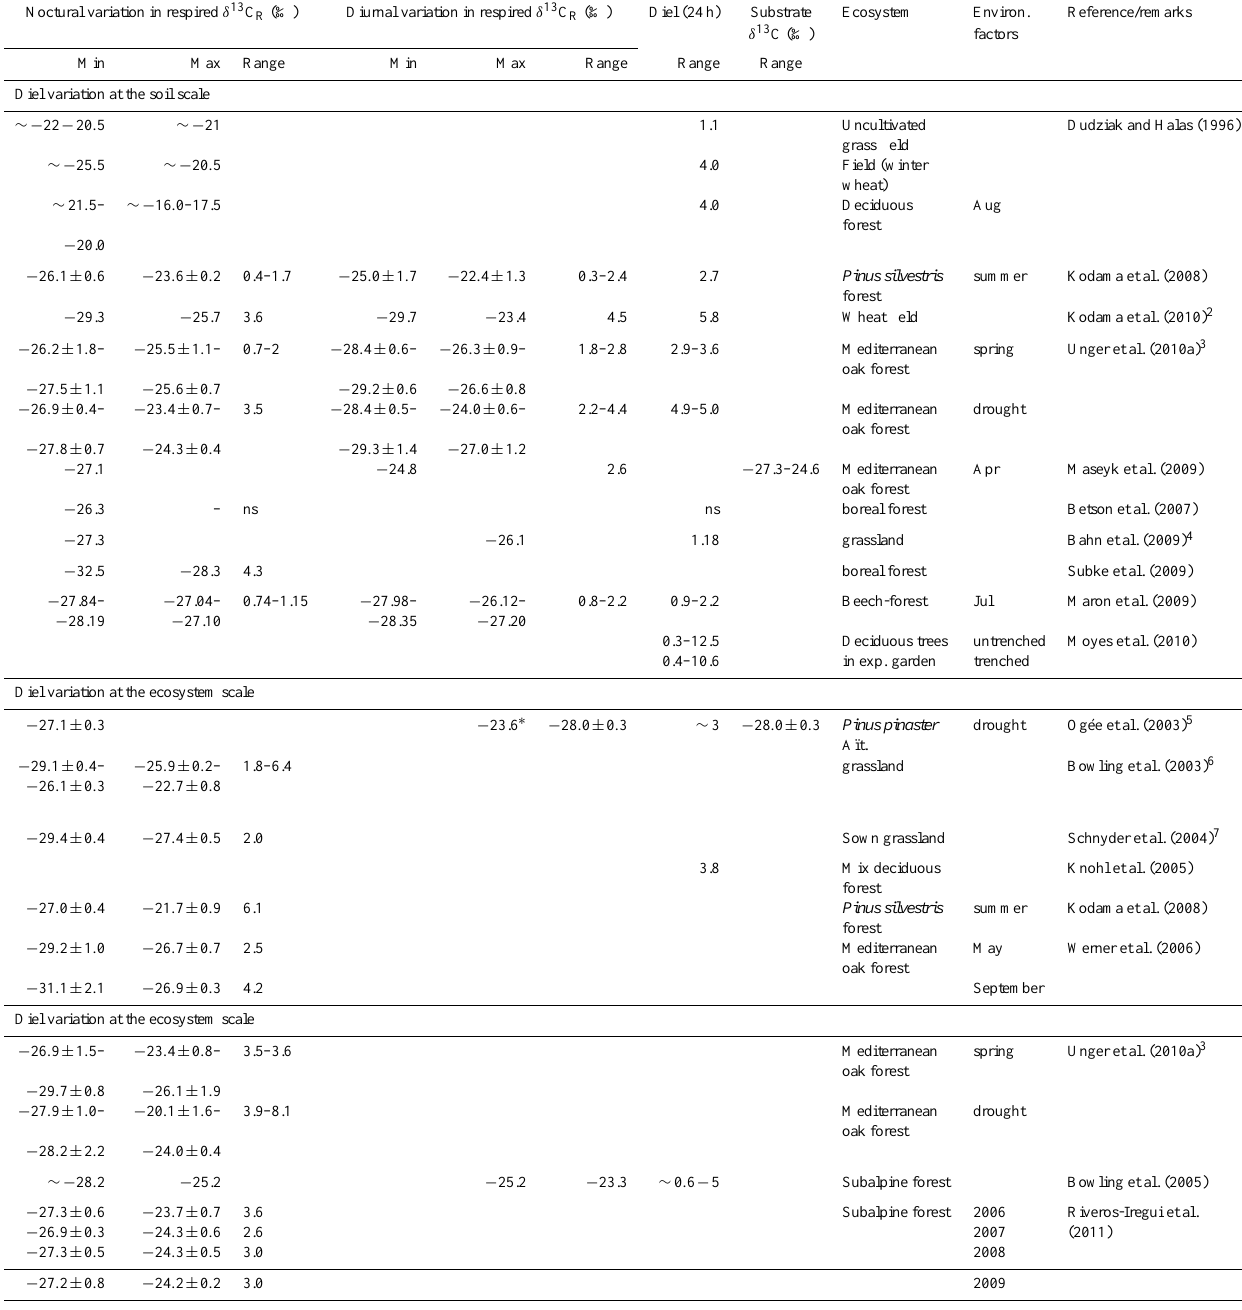
Table 2. Survey on nocturnal, diurnal and 24h-variations in respired δ 13 C R (minimum, maximum and total range) and the variation of the putative substrate (bulk soil OM) of composite fluxes of soil and ecosystem respiration. The ecosystem, environmental conditions and references are given. When several diel courses were available, the variation in the minimum, maximum and range over the measured period was given. ns – not significant; – not